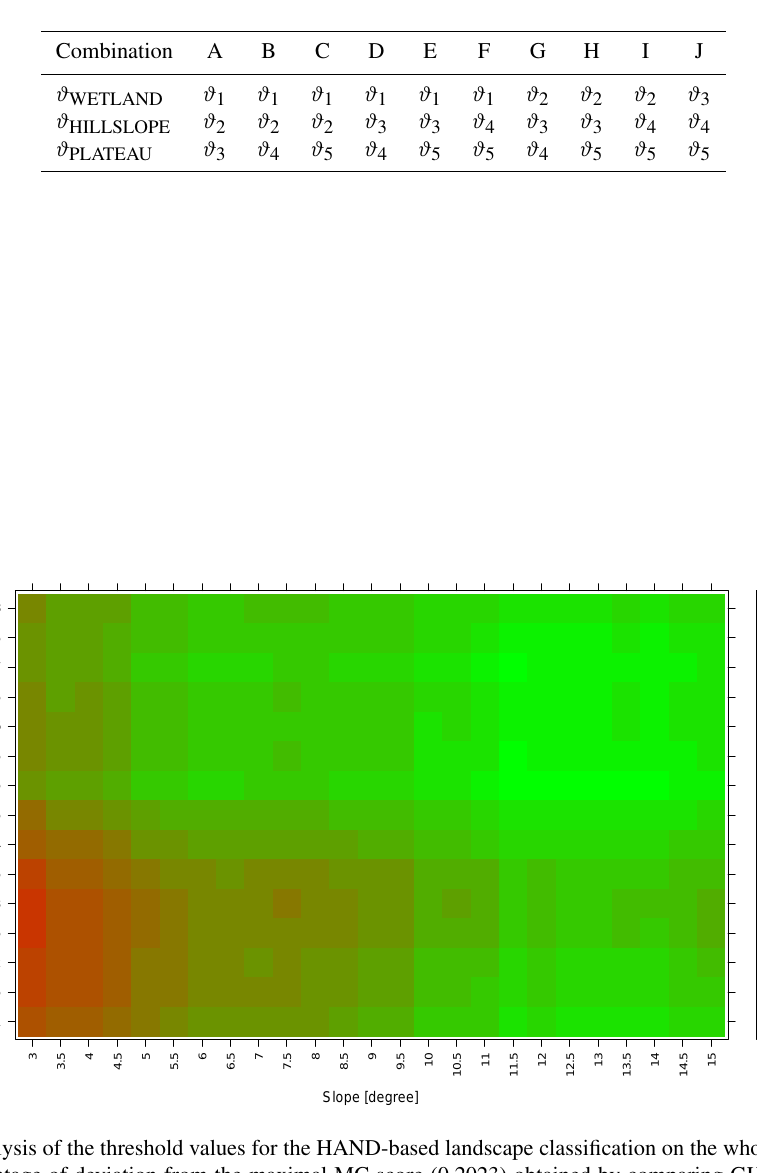
Table A3. Parameter combinations for the simulations driven by the GH11 maps. ϑ = SGRLUZ, K0H, K1H, CPERC. Subscripted numbers refer to the RTs.